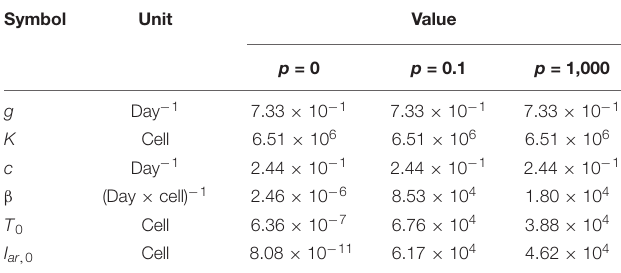
TABLE 2 | Estimated parameters by fitting the mathematical model to experimental